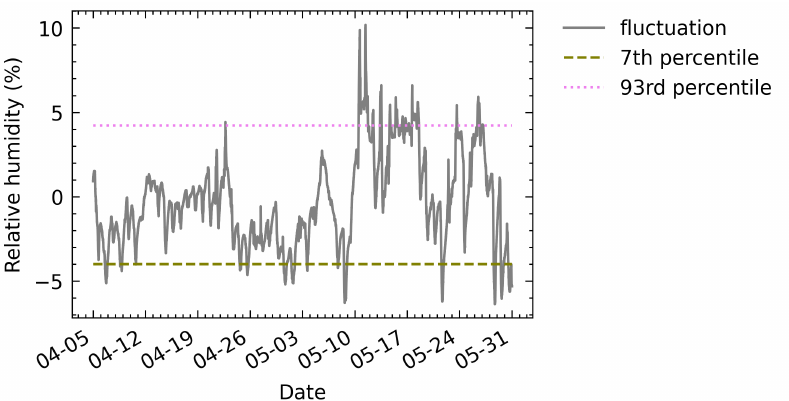
Figure 15. Target range of relative humidity fluctuations. Lower and upper limits of the range are calculated as the 7th and the 93rd percentiles of the fluctuation magnitudes, respectively.